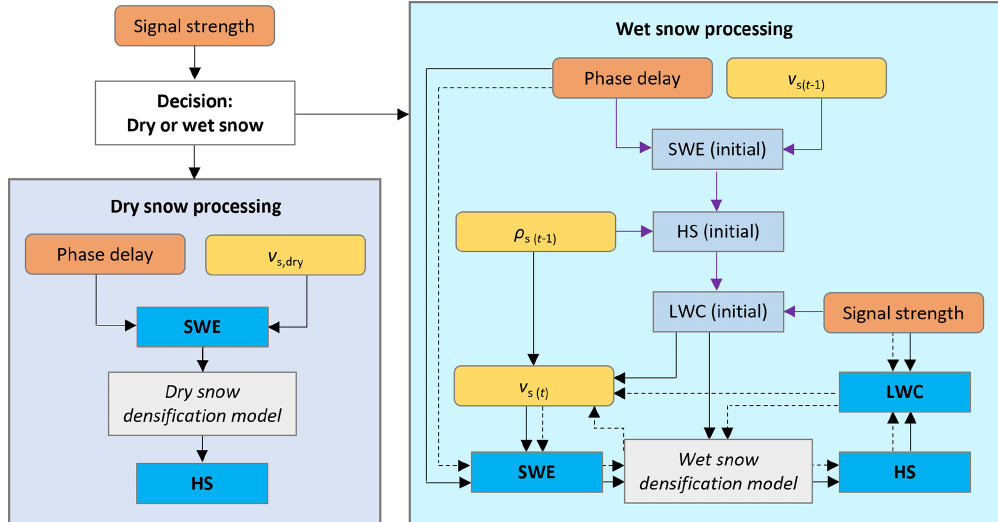
Figure 2. Diagram illustrating the main processing steps for the derivation of the snow cover properties SWE, LWC and HS (blue boxes) using as GNSS input phase delay, derived from the differential carrier phase measurements and signal strength (orange boxes). Snow density and the velocity of signals in dry and wet snow are additional inputs or intermediate variables (yellow boxes). For dry snow, the processing is straightforward, and a constant value v s , dry = 2.3 × 10 8 ms − 1 is assumed. Regarding the wet-snow processing chain, SWE, HS and LWC are first derived as initial values (violet arrows) using snow density ρ s and the velocity v s information of the previous time step; in a second step (black arrows), two iterative calculation steps (second circulation is marked with dashed lines) follow to derive the final